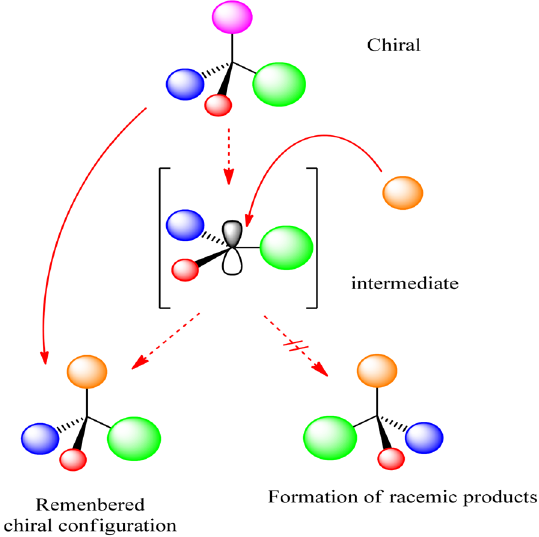
Figure 1. Racemic product formation from an enantiopure starting